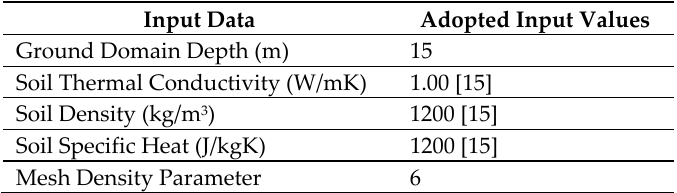
Table 3. Input data considered in GDomain